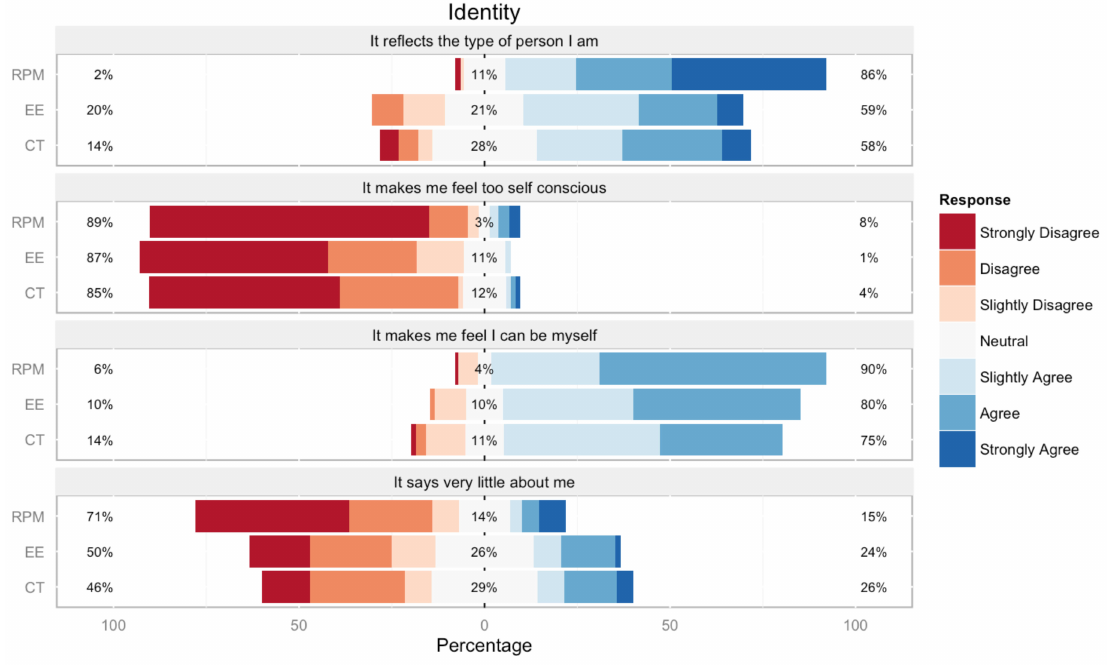
Figure 12. Summary statistics of attitudinal questions regarding Identity among the three locations (By